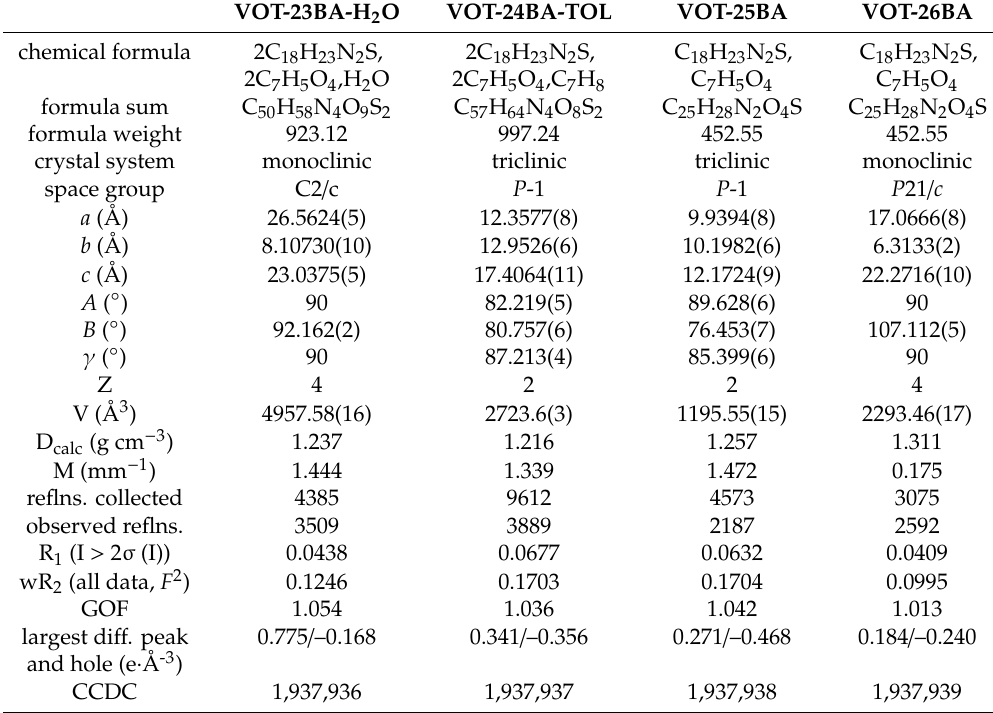
Table 1. Crystallographic parameters of vortioxetine and its dihydroxybenzoic acid